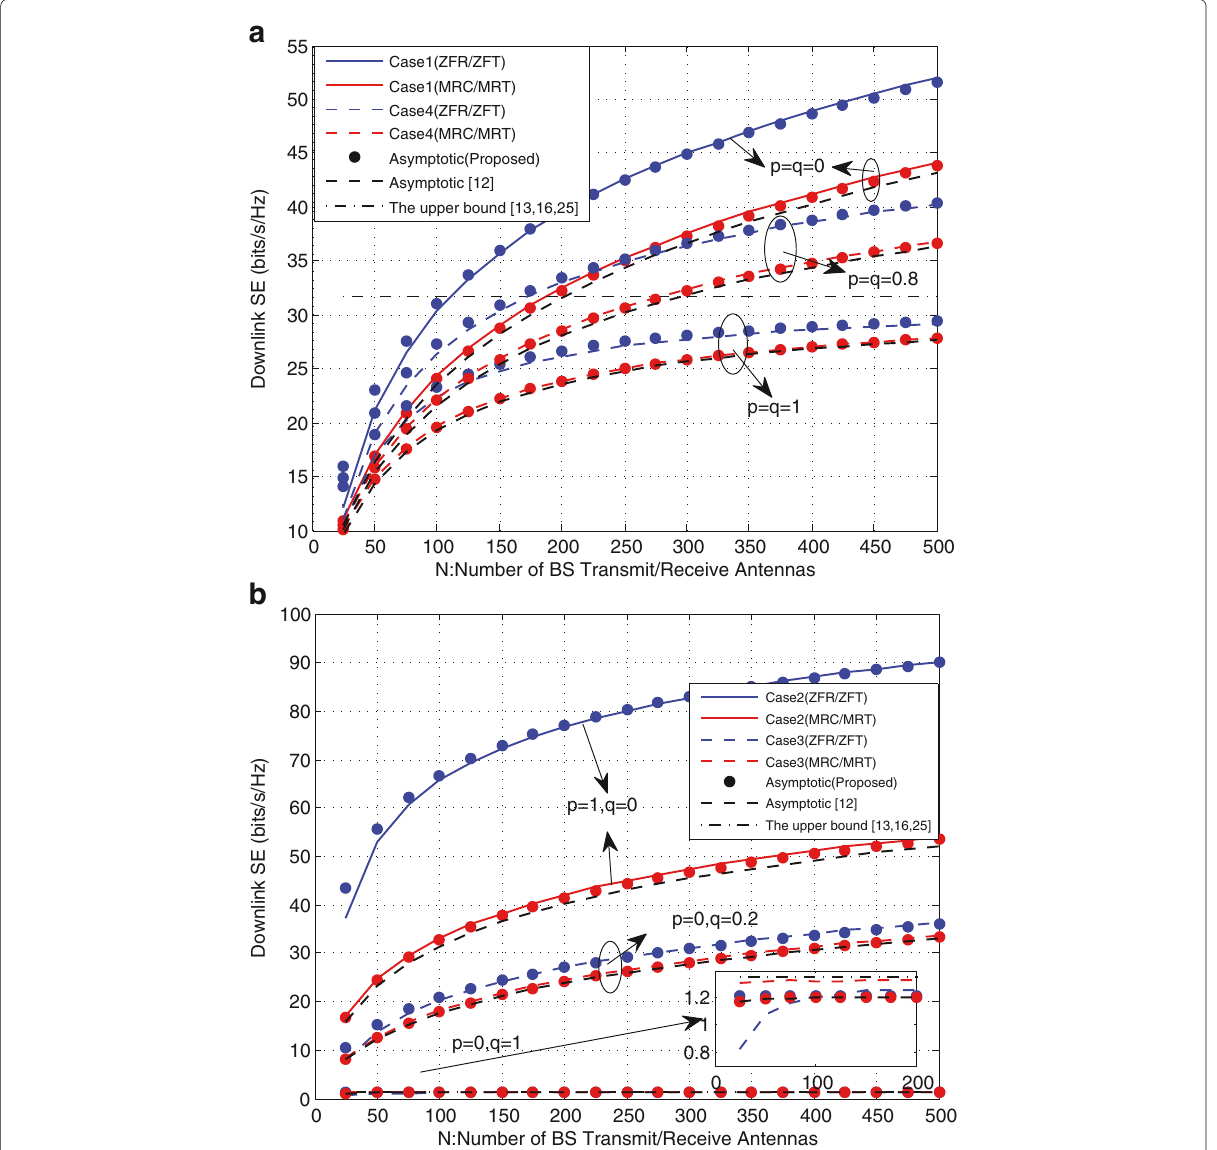
Fig. 3 a Downlink SE for cases 1 and 4. b Downlink SE for cases 2 and 3. Comparison of downlink SE for four power scaling schemes versus N with